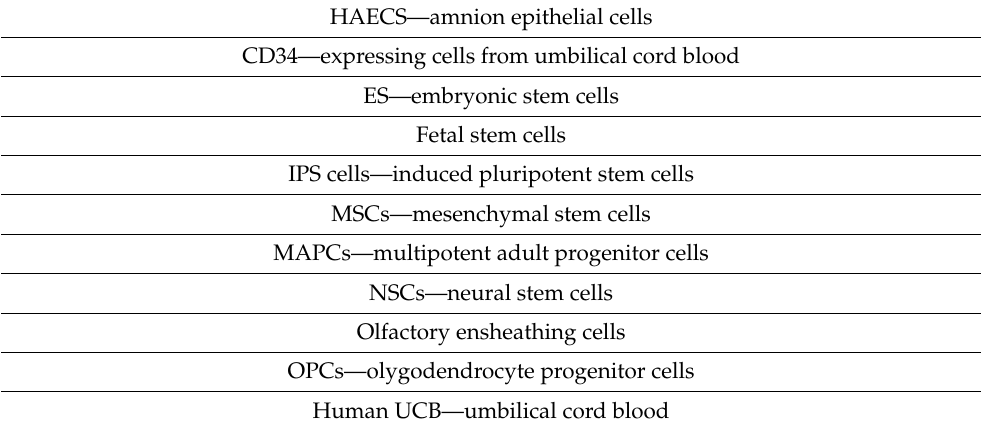
Table 6. Stem cell types promising in the treatment of cerebral palsy.